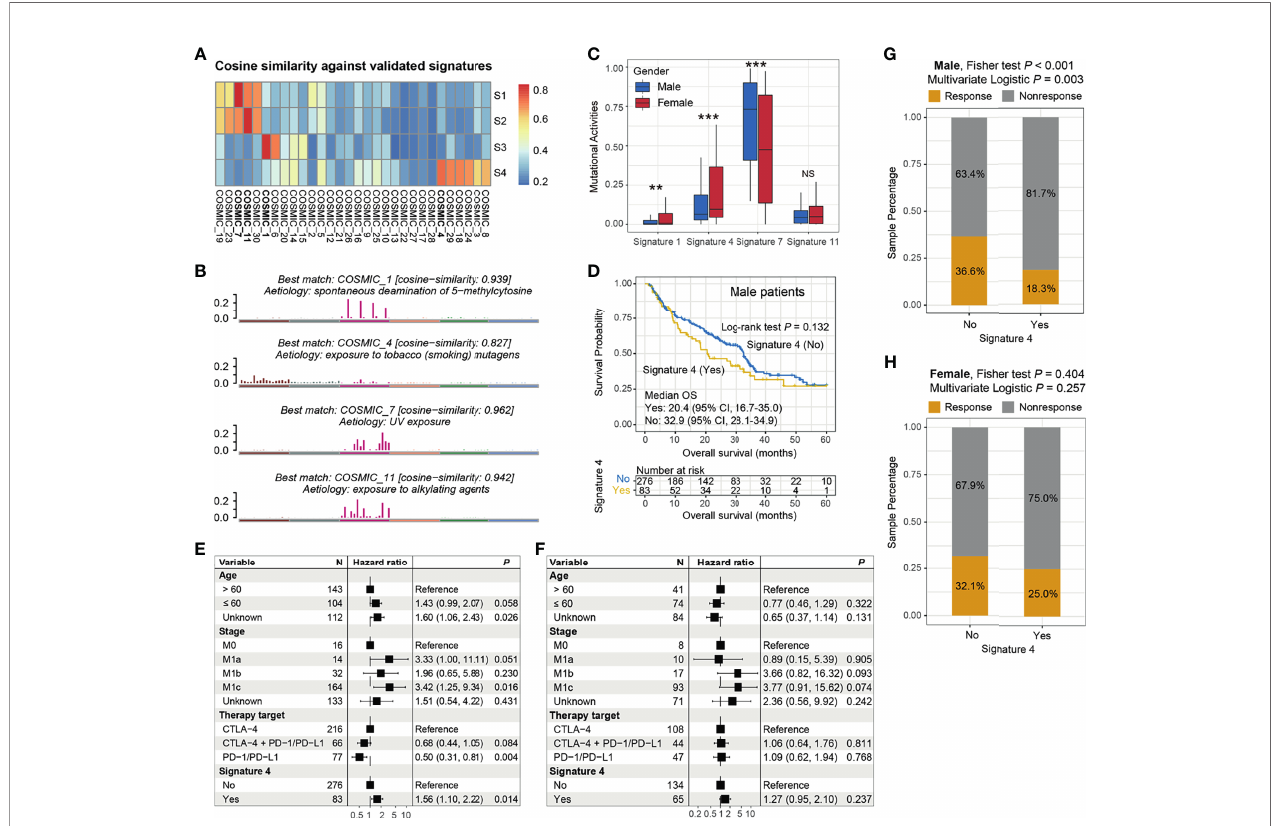
FIGURE 4 | Determination of melanoma mutational signatures and their sex biases with respect to ICI ef fi cacy. (A) Heatmap representation of the cosine similarities between the extracted four mutational signatures and 30 COSMIC signatures. (B) Identi fi cation of the four mutational signatures with speci fi c etiology according to the COSMIC nomenclature. (C) Distinct activities of the identi fi ed four mutational signatures between male and female subgroups. (D) Kaplan – Meier survival curves strati fi ed by signature 4 status in male melanoma patients. Forest plot illustration of the associations of signature 4 with ICI overall survival in (E) male and (F) female patients. Bar plots representation of the associations of signature 4 with ICI response rate in (G) male and (H) female patients. ** P < 0.01; *** P < 0.001; NS, not signi fi